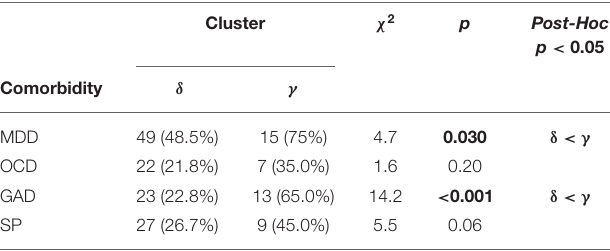
TABLE 5 | Comparison comorbidity frequencies based on 2 ( δ and γ ) clusters (Pearson’s χ 2 test). Cluster χ 2 p Post-Hoc